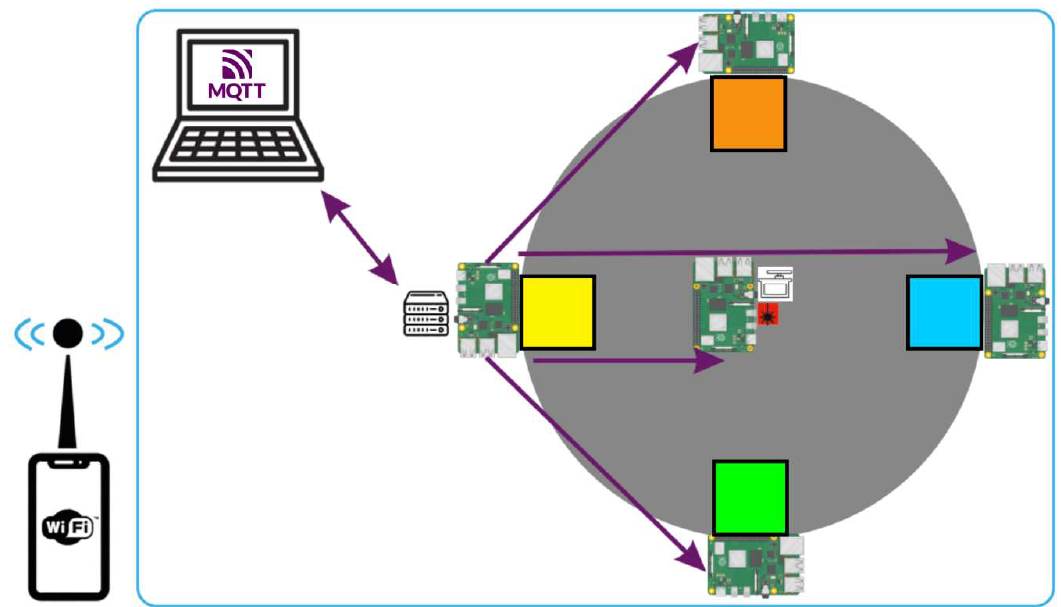
Figure 2. Global architecture and connections scheme. Android device (left) sharing a WiFi access point (represented by the blue square where every device is). Laptop sending and receiving MQTT messages from and to the Raspberry Pi that acts as broker (server icon on the left) placed in a column of the circular structure (grey circle). Every other Raspberry Pi in the columns and ceiling (the center one) reads messages and act accordingly, either changing the output of the screens (represented as colored squares) or shining a laser on the floor or taking pictures in the case of the Raspberry in the roof.